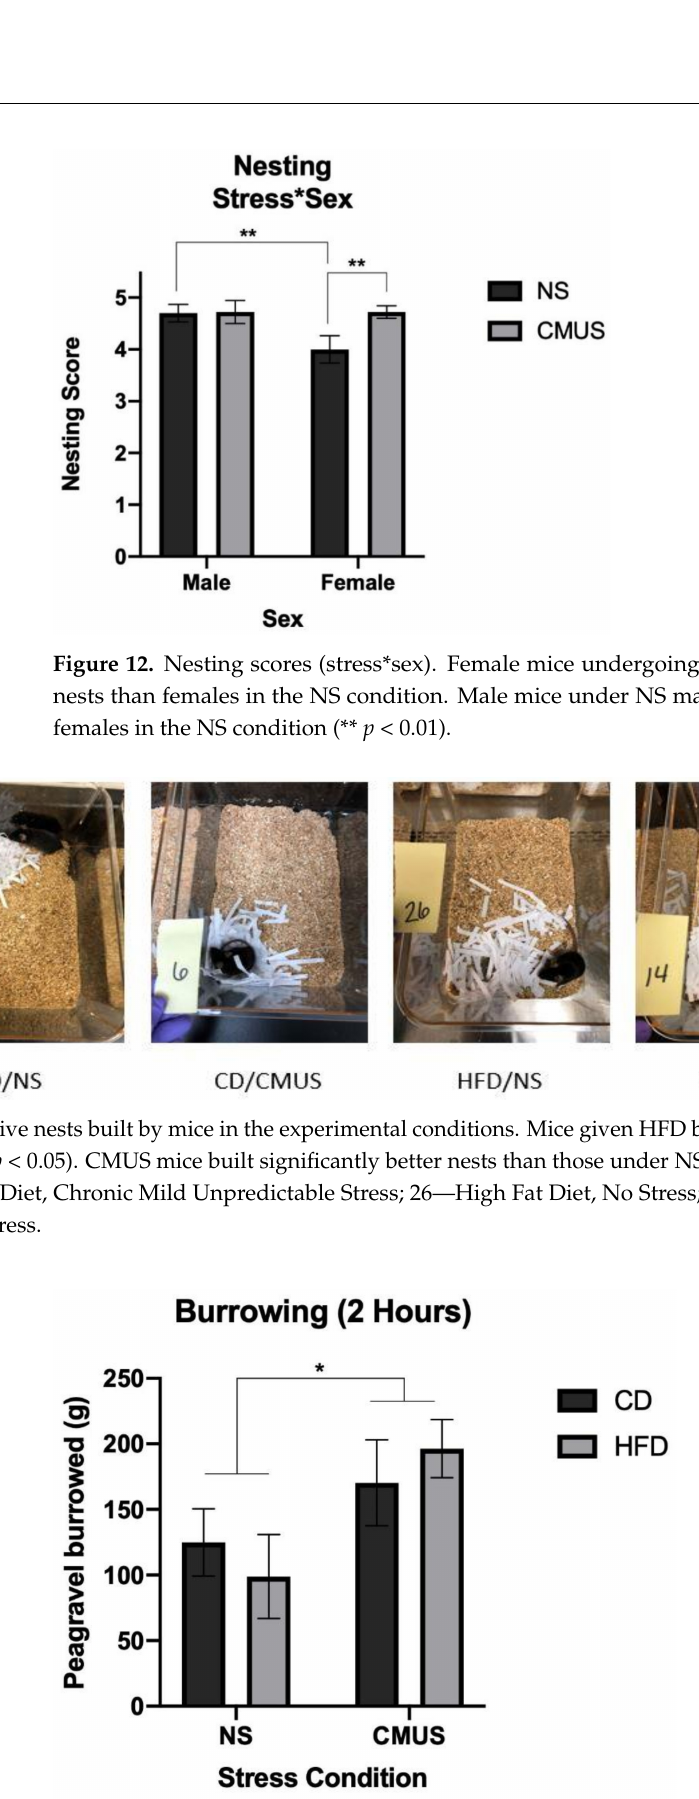
Figure 14. Burrowing behavior after 2 h. CMUS mice burrowed significantly more pea-gravel than NS mice (* p <